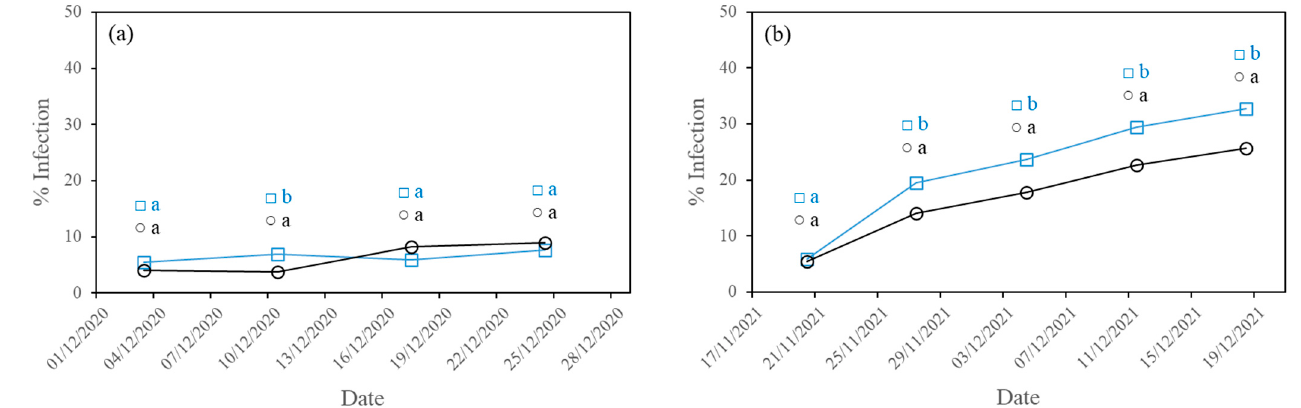
Figure 5. Development of gummy stem blight ( D. bryoniae ) percentage of infection over time, for the first crop cycle ( a ) and for the second crop cycle ( b ). Sector with commercial film C F ( □ ); Sector with experimental film E F ( ○ ). Different letters indicate statistically significant difference ( p -value ≤ 0.95).